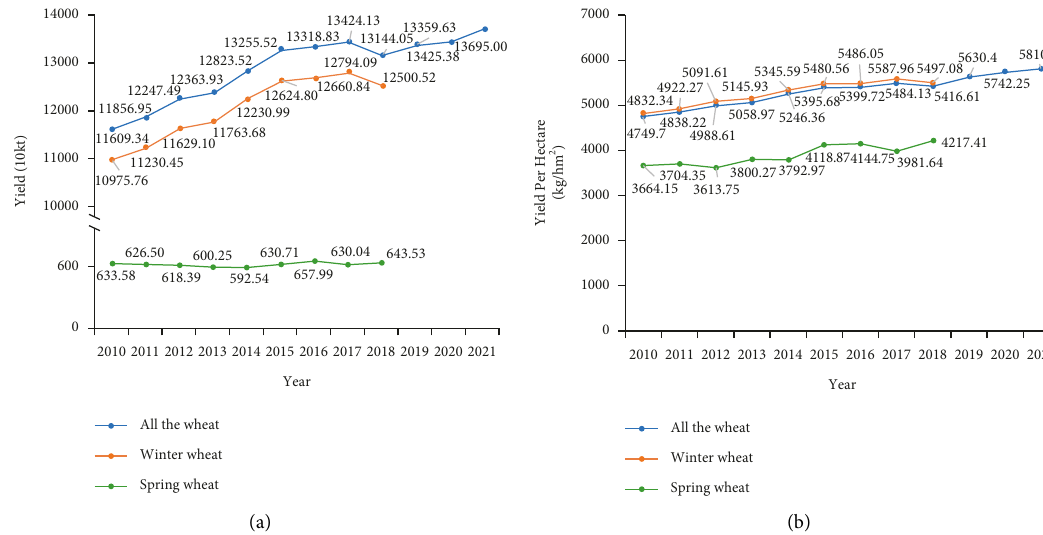
Figure 4: The total annual yield and average yield per hectare of wheat in China from 2010 to 2021. (a) The total annual yield of wheat in China from 2010 to 2021; (b) the average yield per hectare of wheat in China from 2010 to 2021. The annual yield and average yield per hectare of winter and spring wheat in 2019–2021 was with no records in the website of National Bureau of Statistics of China (https://data.